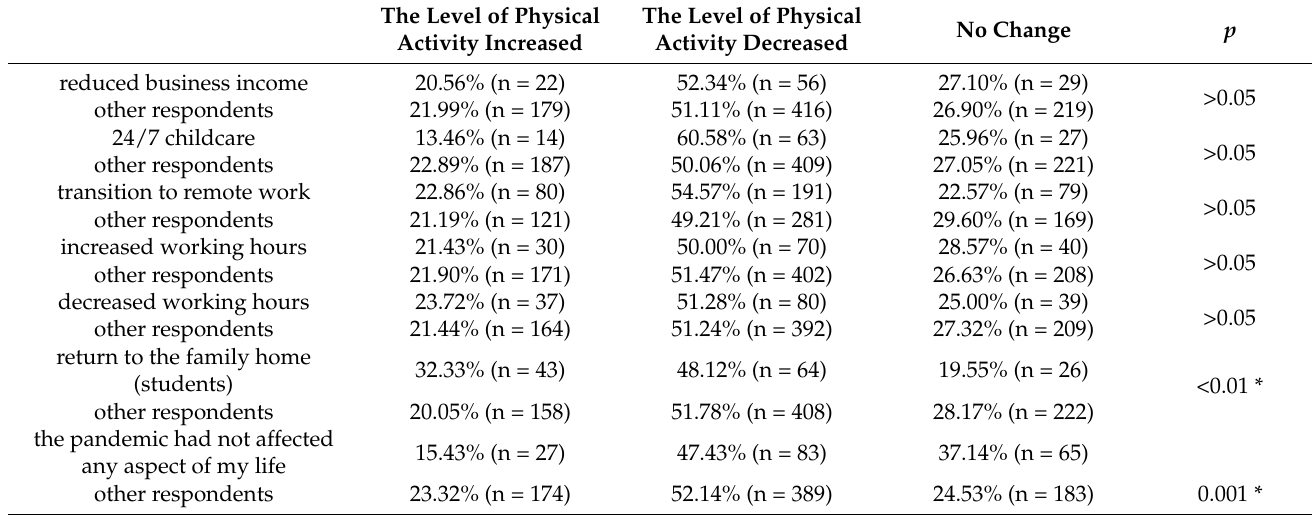
Table 5. Change in the level of physical activity acc. to life situation during the